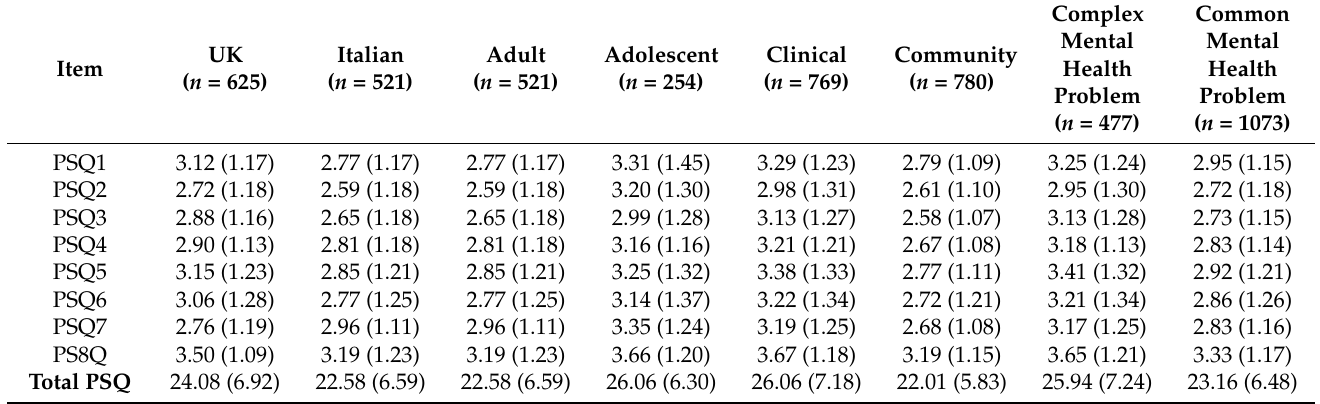
Table 3. Mean item PSQ item score and total PSQ scores with standard deviations (SD) for each